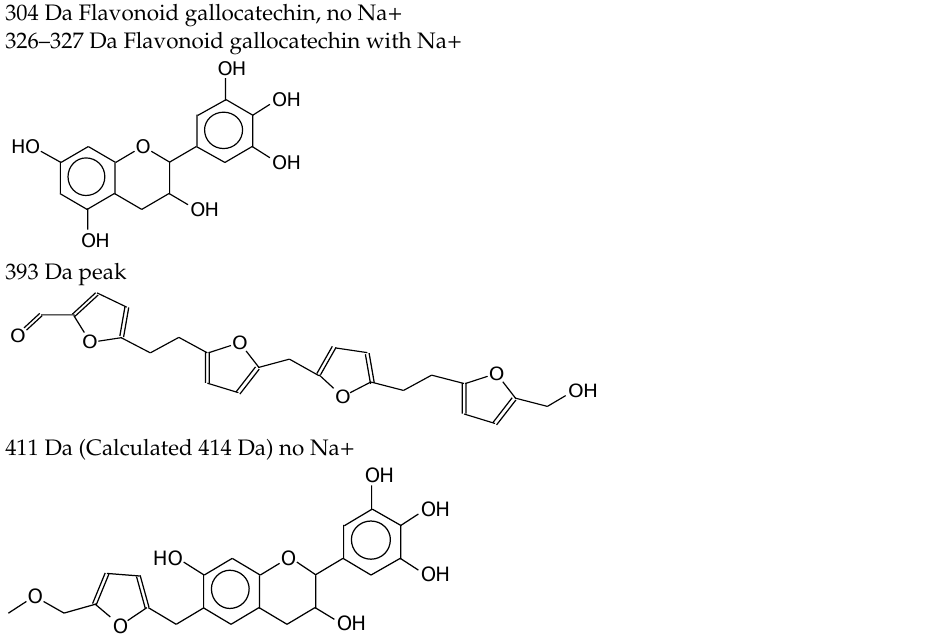
427 – 428 Da (Calculated 430) no Na+ reaction of a flavonoid with the humins aldehyde at 141 Da